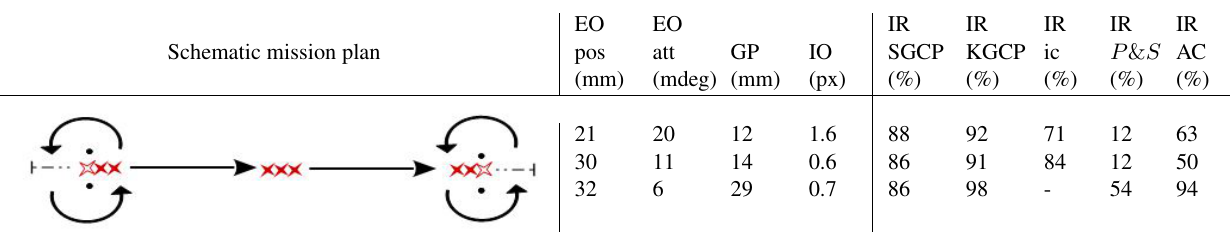
Table 4: Precision and internal reliability results for the mapKITE corridor using σ λ = 1000